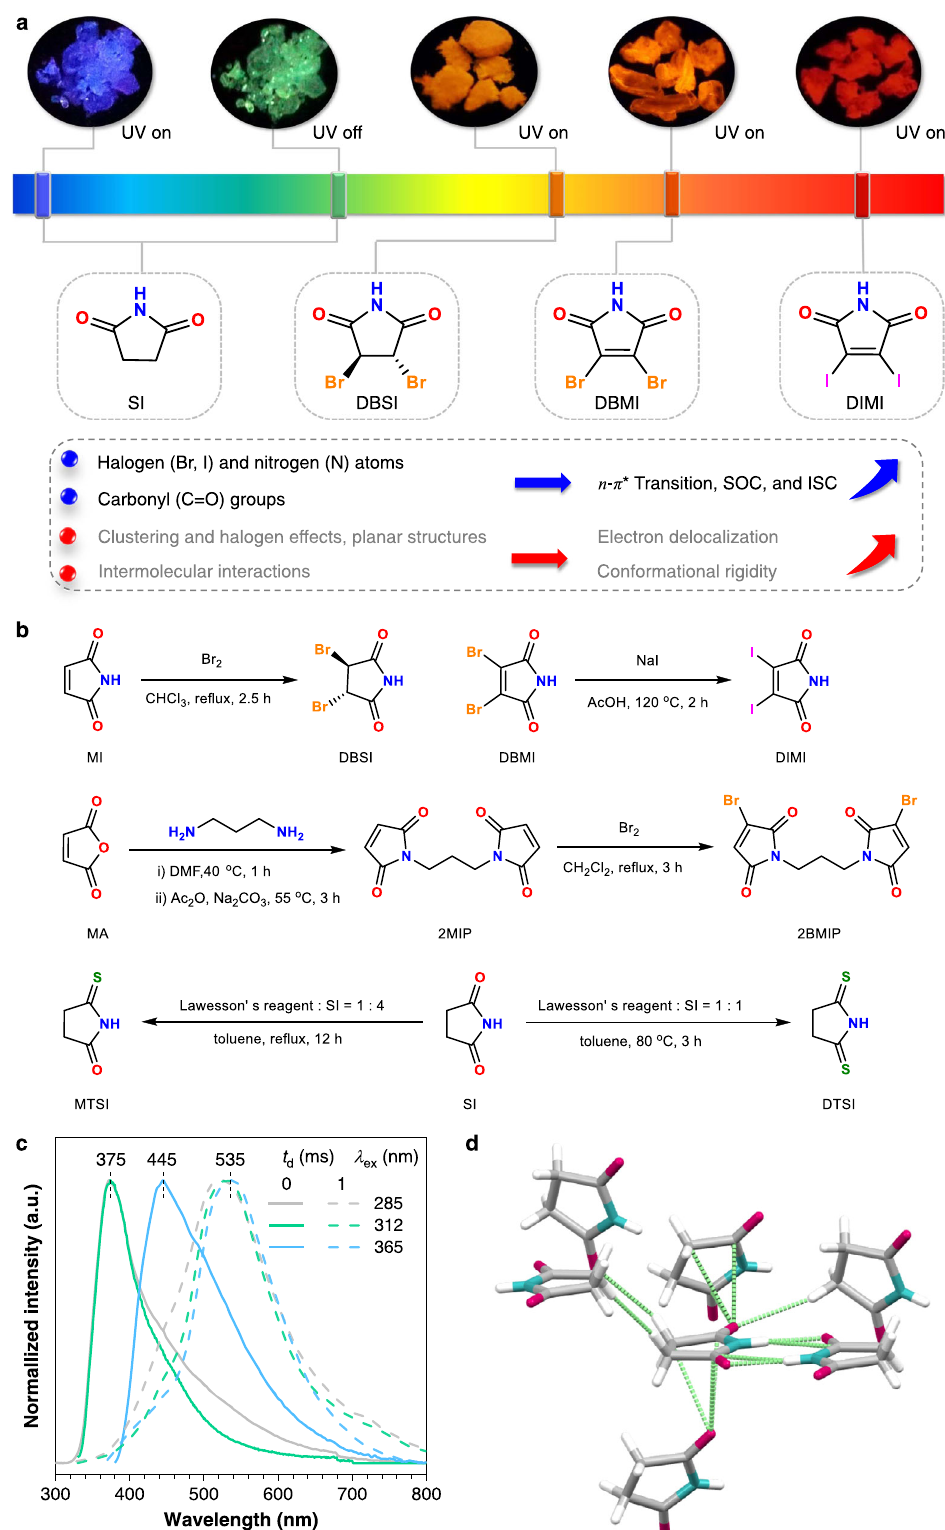
Fig. 1 Design considerations, synthetic routes, and photophysical properties of SI and its derivatives. a Structure, luminescent photographs of the crystals, and design considerations of SI, DBSI, DBMI, and DIMI. b Synthetic routes to different luminophores studied herein. c Prompt and delayed emission spectra of SI crystals. d Single-crystal structure, fragmental molecular packing, and intermolecular interactions around one molecule of SI.